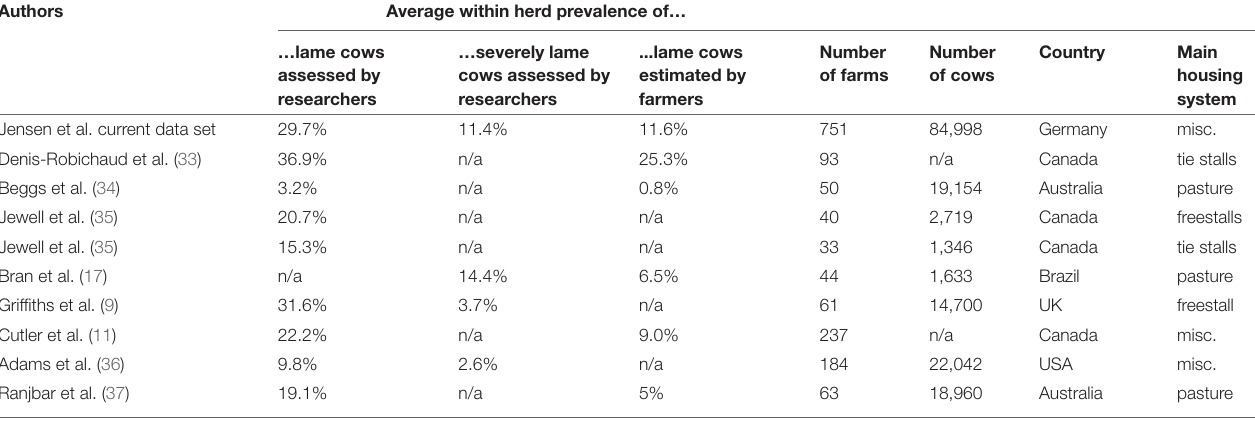
TABLE 8 | Studies published during the last 5 years reporting the prevalence of lame